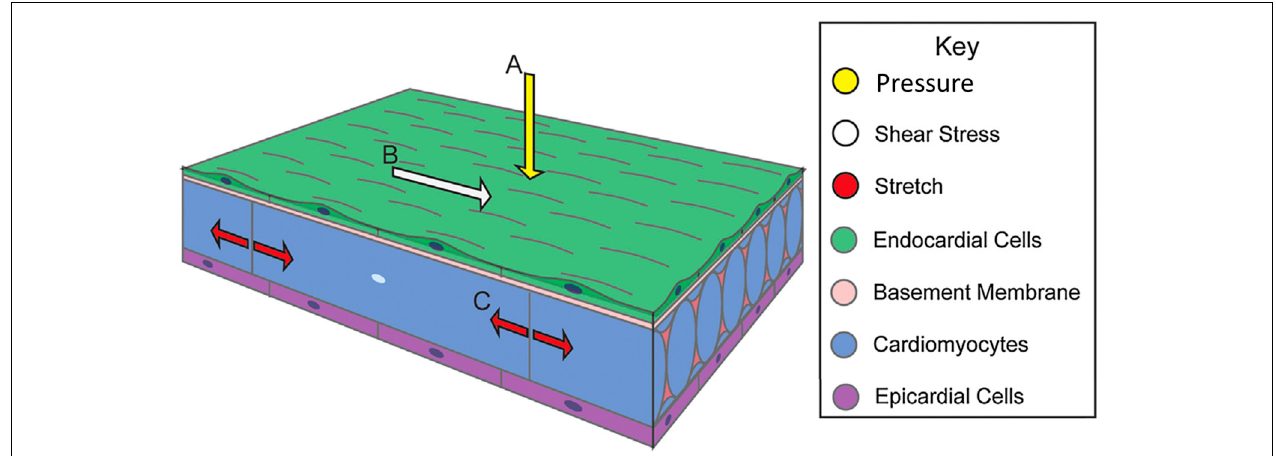
FIGURE 1 | Biomechanical forces in cardiac wall maturation. Biomechanical forces are important for normal developmental patterning. Forces exerted on the wall from blood flow include (A) pressure, a force